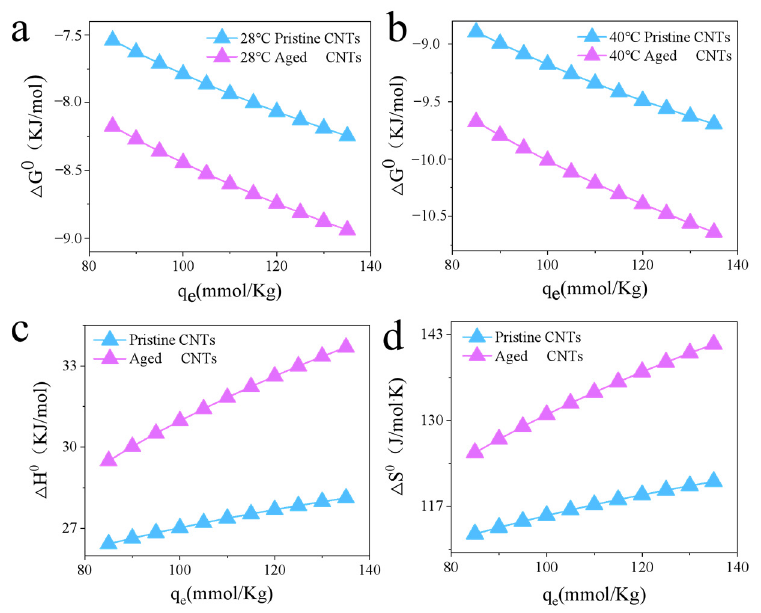
Figure 5. △ G 0 ( a , b ), △ H 0 ( c ) and △ S 0 ( d ) of TC adsorption on pristine and aged CNTs. Figure 5. ∆ G 0 ( a , b ), ∆ H 0 ( c ) and ∆ S 0 ( d ) of TC adsorption on pristine and aged